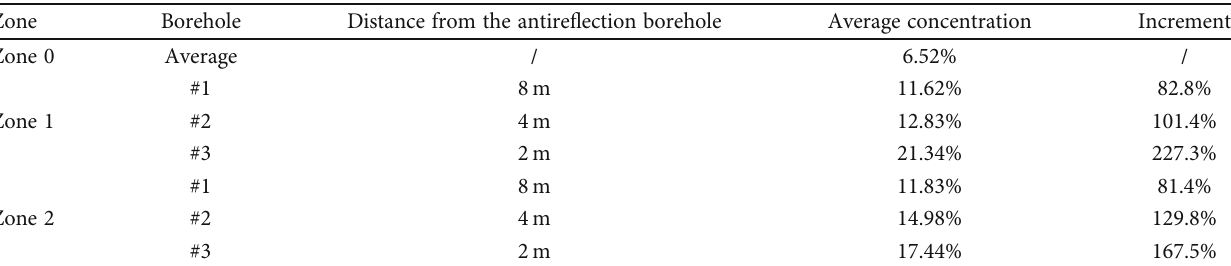
Figure 3: Change curves of the gas concentration in drainage borehole. Table 1: Data analysis of gas concentration in